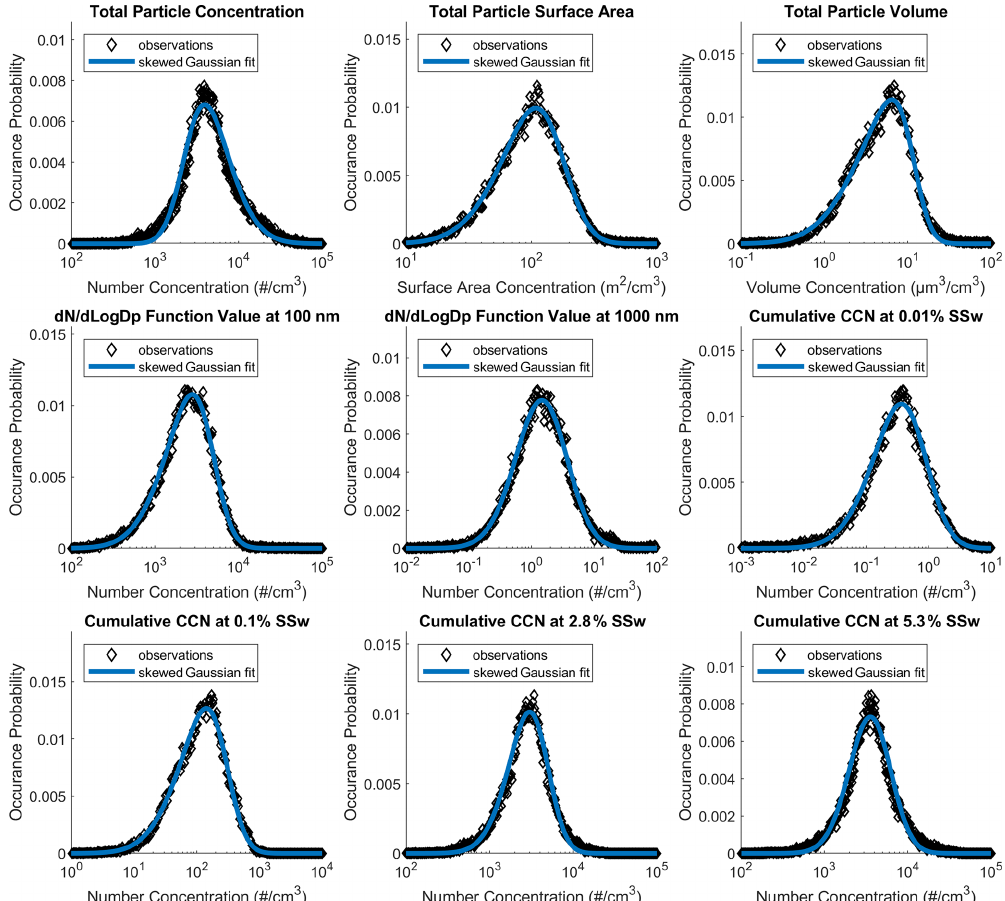
Figure B1. Examples of skewed log-normal fits to occurrence probabilities for aerosol metrics are labeled as follows: total particle number, total particle volume, d N / dLog D p function at 100nm, d N / dLog D p function at 1000nm, and particle number concentrations active as CCN at 0.01%, 0.1%, 2.8%, and 5.3% SS w